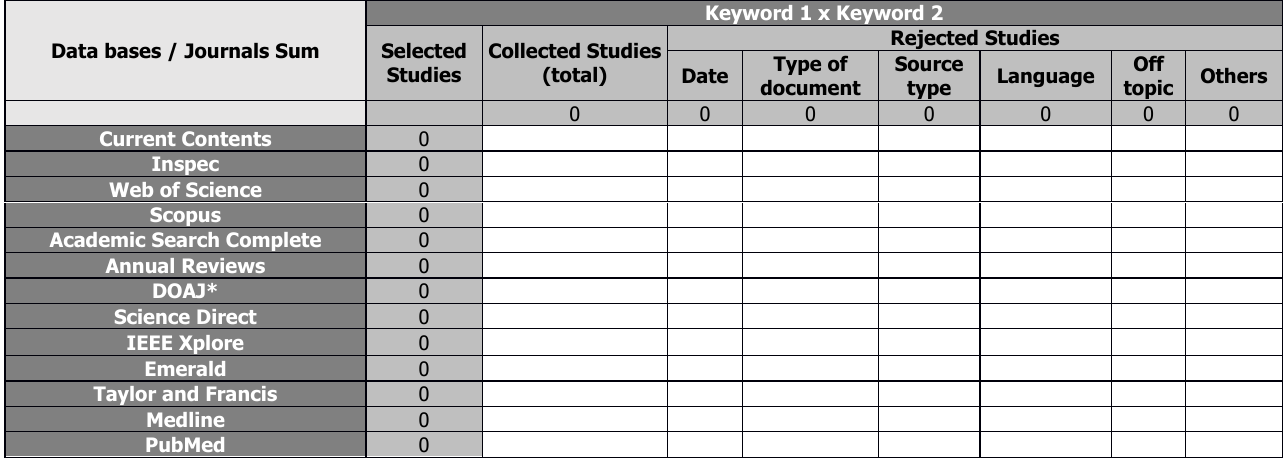
Table 1 – Form sheet summarizing the rejection criteria which will be used to conduct the systematic